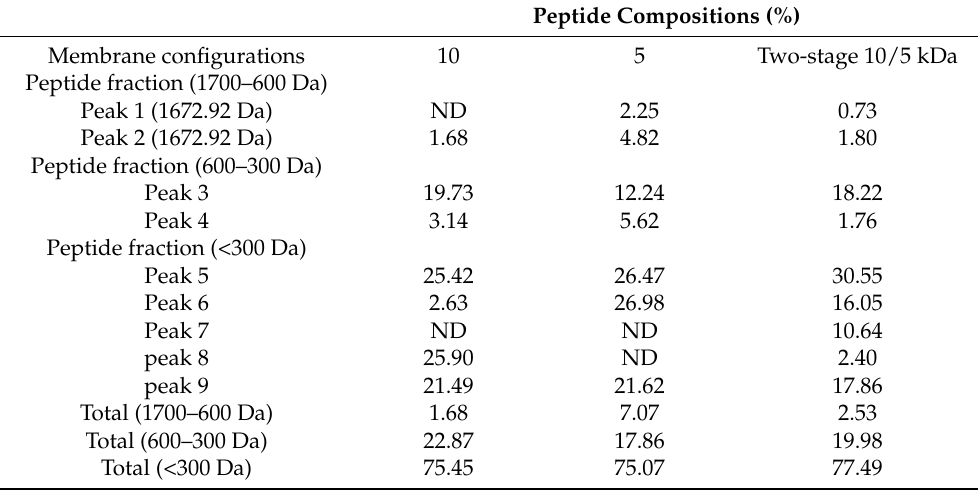
Table 1. Peptide composition of microalgae protein hydrolysate (MPH) at different membrane